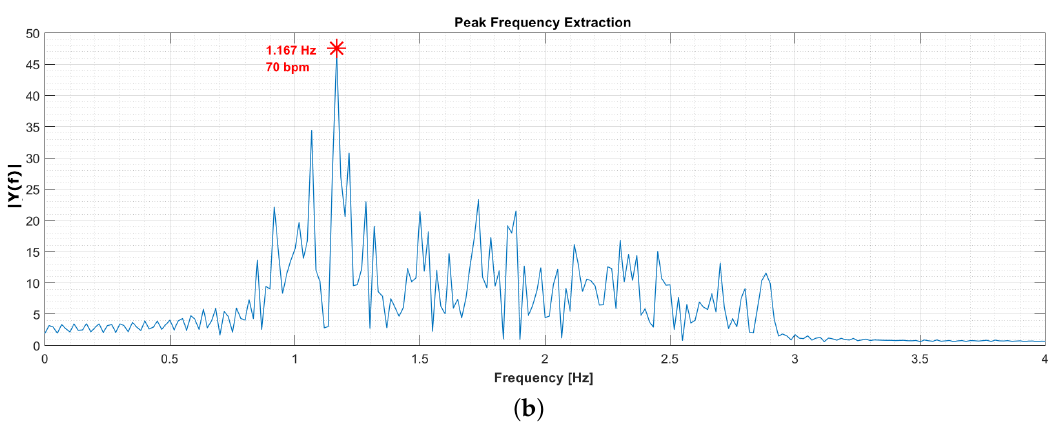
Figure 4. VPG signal (Y-component) obtained by averaging the signals of all of the ROIs (F, C, N or, rather, ROI T (Total)) over one test execution. The signal is represented in the time domain ( a ) and in the frequency domain ( b ), after the bandpass filtering process.